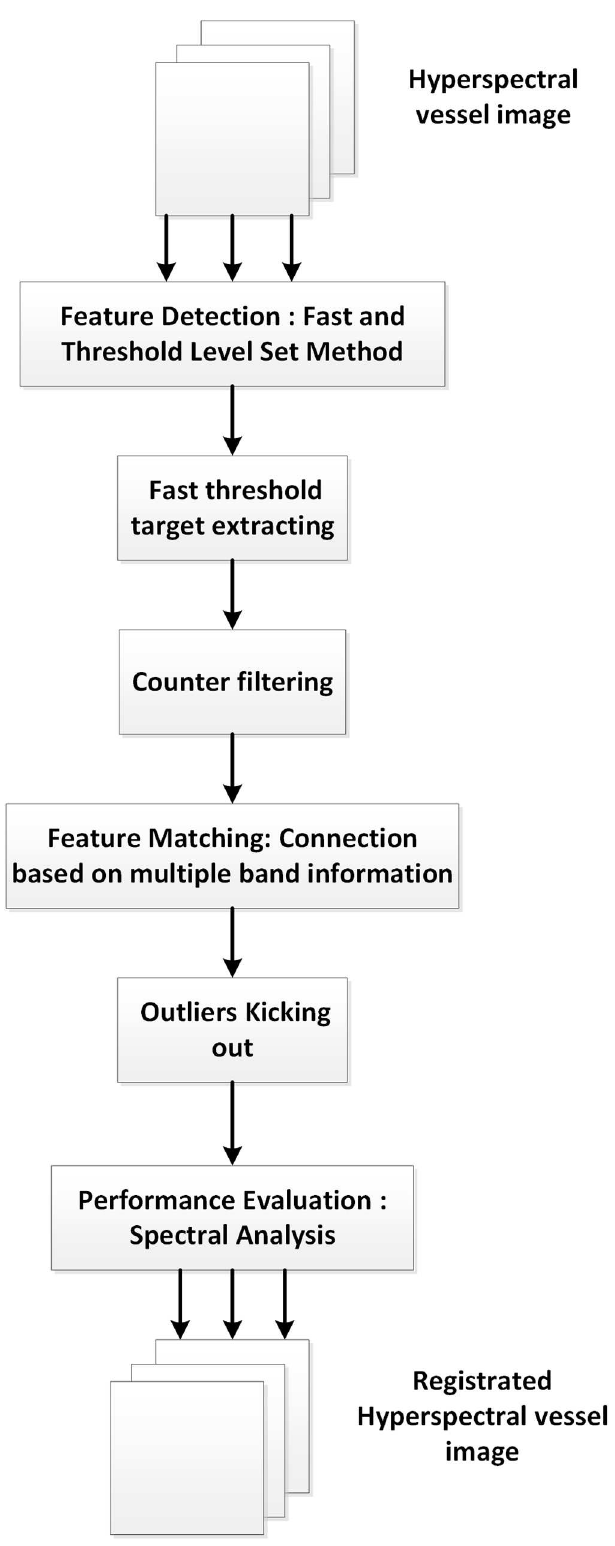
Fig 1. Flow of the proposed hyperspectral vesselimage registration scheme.